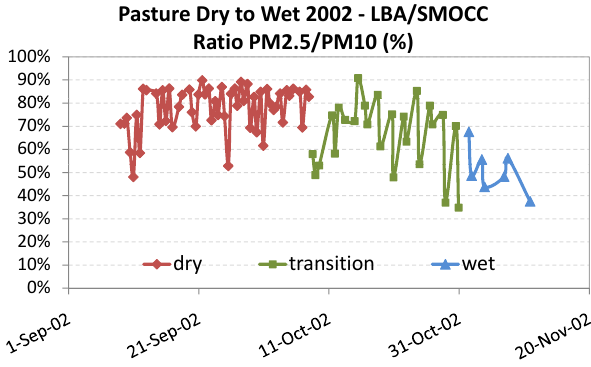
Fig. 5. Percent contribution of PM 2 . 5 to PM 10 aerosol mass con- centration during the LBA/SMOCC experiment, based on gravimet- ric analysis of polycarbonate filters. The percentage of PM 2 . 5 de- creases from dry to wet season, in accordance with the shift from biomass burning to biogenic aerosols.